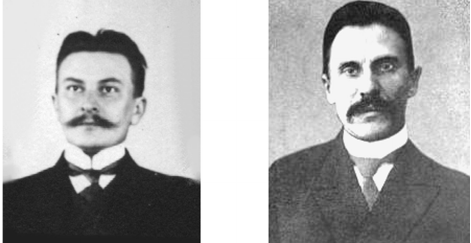
Fig. 1. T. Banachiewicz (left) (from: A. K. Zawada \Observo ergo sum") and K. D. Pokrovsky (right). Source: http://www.psu.ru/?picview=19